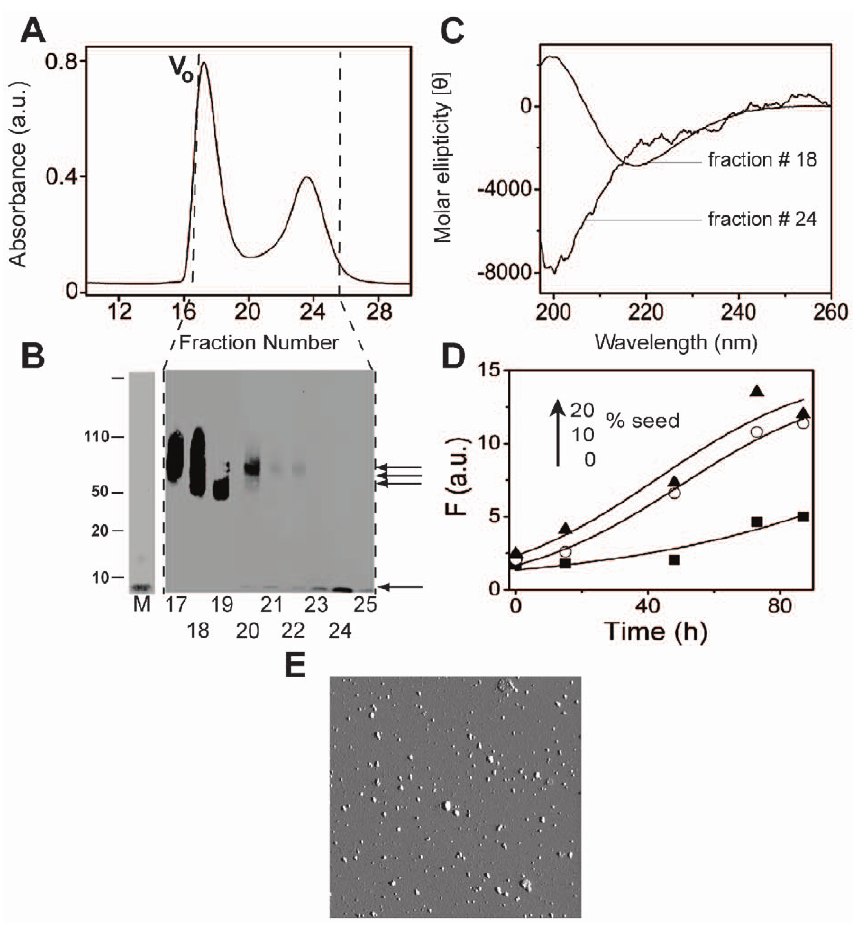
Figure 8. Oligomeric 12–18 mers can be isolated and characterized. A b 42 (50 mM) was incubated with 5 mM C12 for 48 h at 37 u C to generate 12–18 mers. A) The sample was fractionated on a Superdex-75 SEC with a flow rate of 0.5 ml/min, V o indicates void volume, B) Immunoblots of the fractions, developed with Ab9 antibody indicates the separation of 12–18 mers and monomers, C) Far-UV CD spectra of the fractionated samples, fraction 18 and 24 that show b -sheet and random coil structures respectively. and, D) seeding experiment was performed with 10% ( # ) and 20% ( m ) of fraction 18 as seeds with 25 m M A b 42 monomer at 37 u C Control in the absence of seeds is shown as ( & ) and the data was fit with Eq 1 as in Figure 2. E) AFM image (5 6 5 m m) of fraction 18 (12–18 mer) shows largely a bimodal distribution of spherical